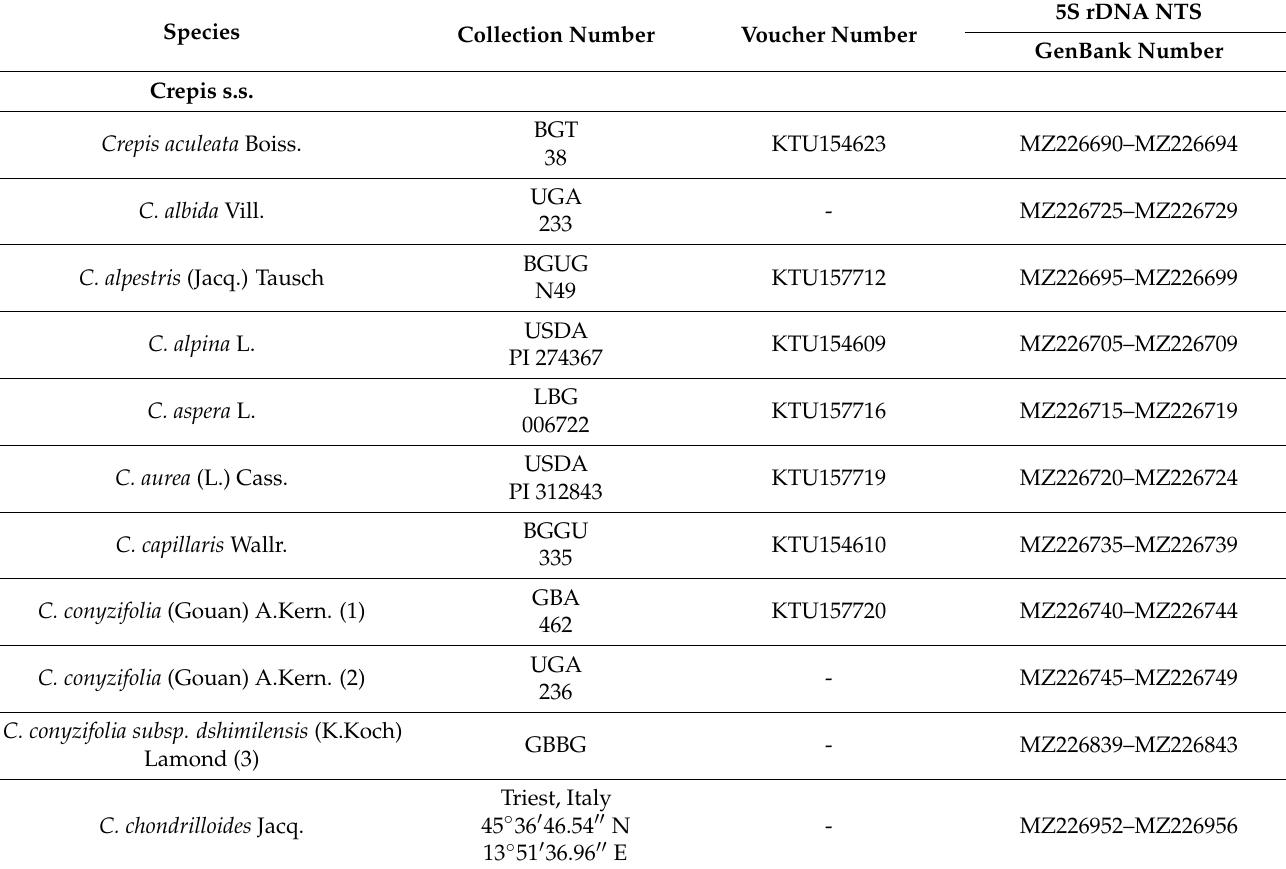
Table 2. Species name, collection number and voucher number of the analysed taxa and GenBank accession numbers of the sequences obtained in this